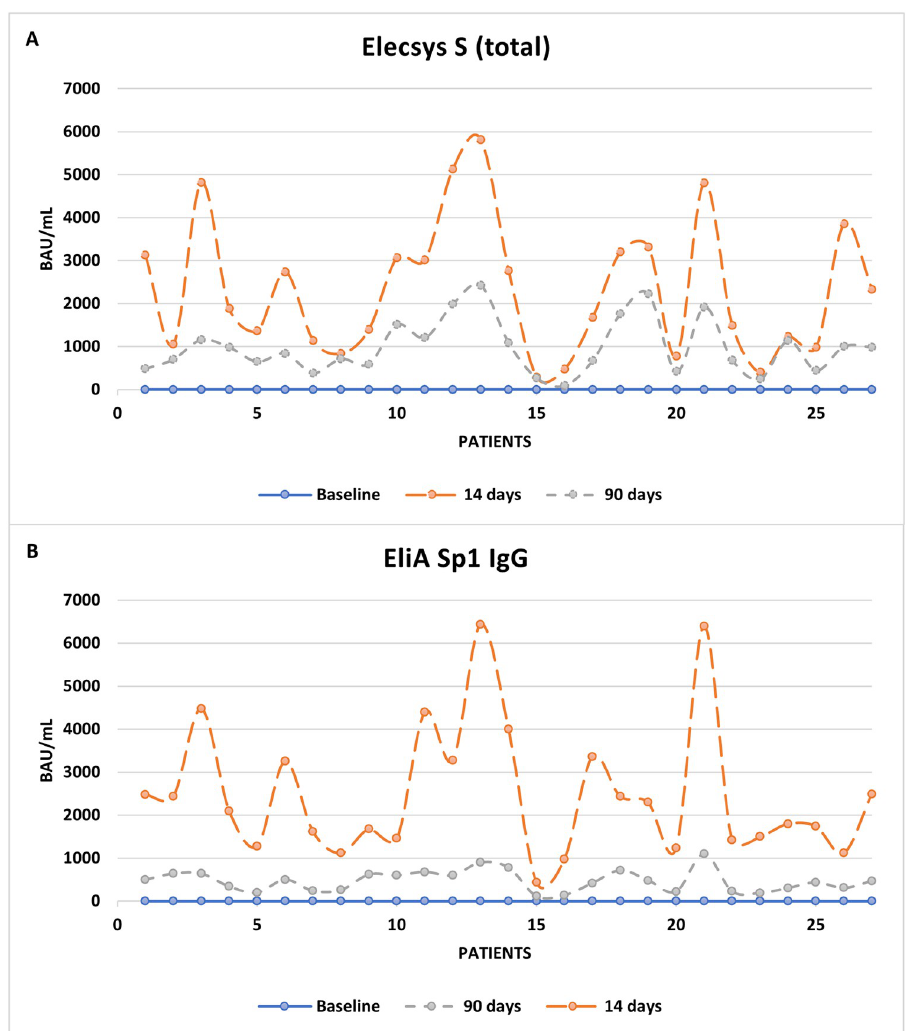
Fig 2. Antibody titer evolution at inclusion, 14 and 90 days after vaccination. A. S protein total antibodies. B . S protein IgG